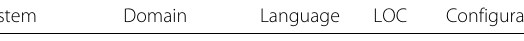
Algorithm 1 Select Best Fault Tolerance Scheme